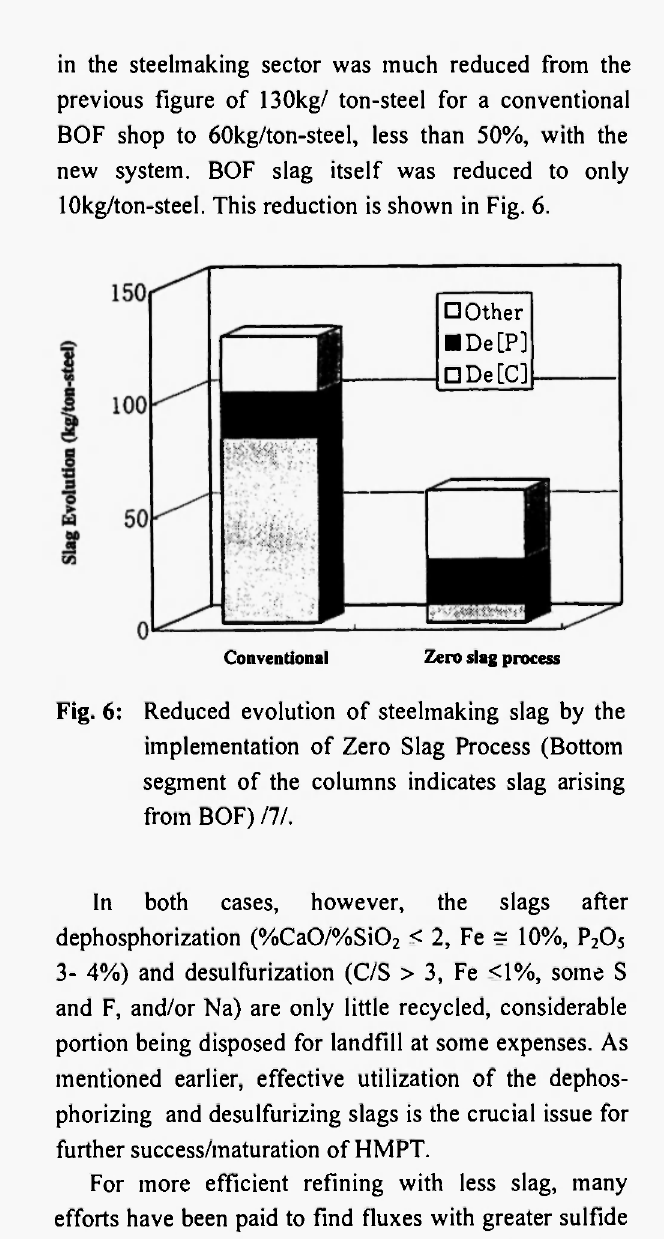
Reduced evolution of steelmaking slag by the implementation of Zero Slag Process (Bottom segment of the columns indicates slag arising from BOF)